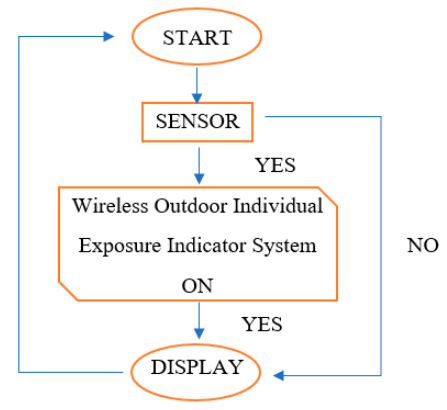
Figure 6. The flow of the system.